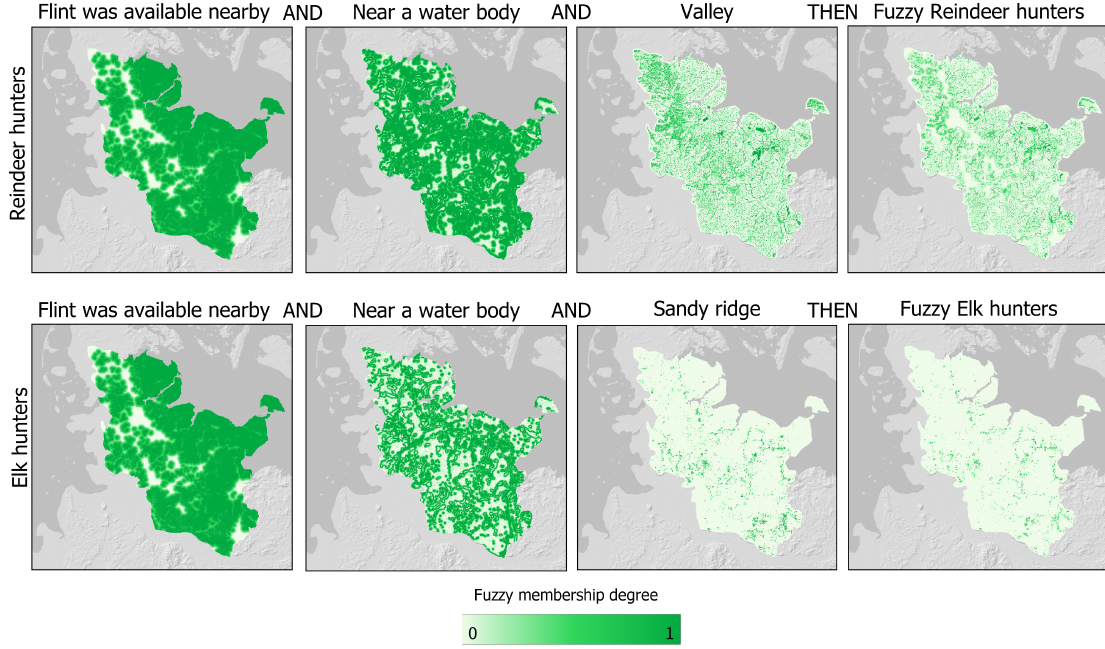
Figure 3. Spatial representation of the fuzzified raster data